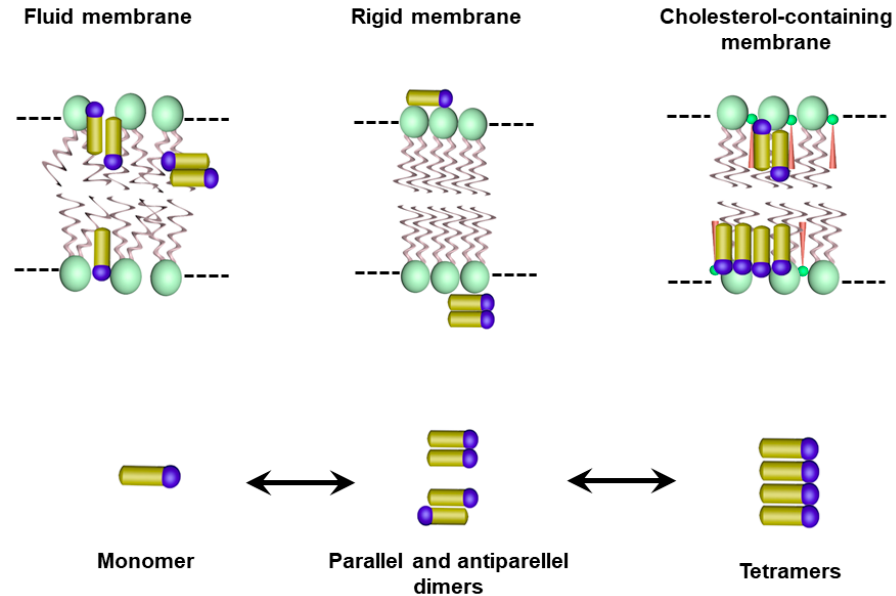
Figure 6. Illustration of the molecular and supramolecular AmB species and their membrane local- ization, as suggested by previous studies of the interaction of AmB with membranes under different physical states.